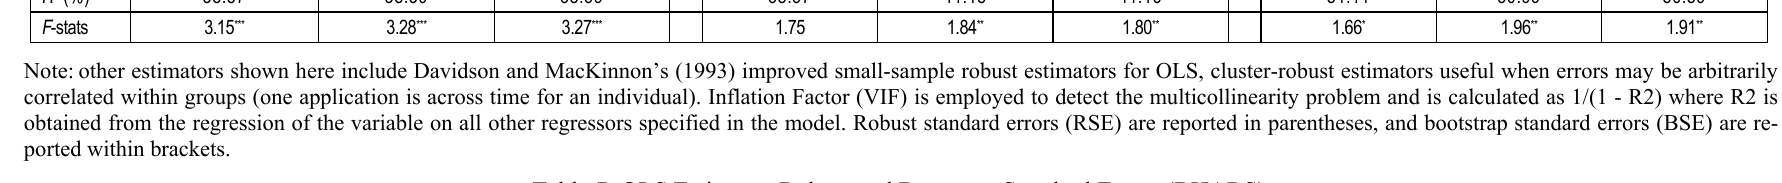
Table 7. OLS Estimates-Robust and Bootstrap Standard Errors